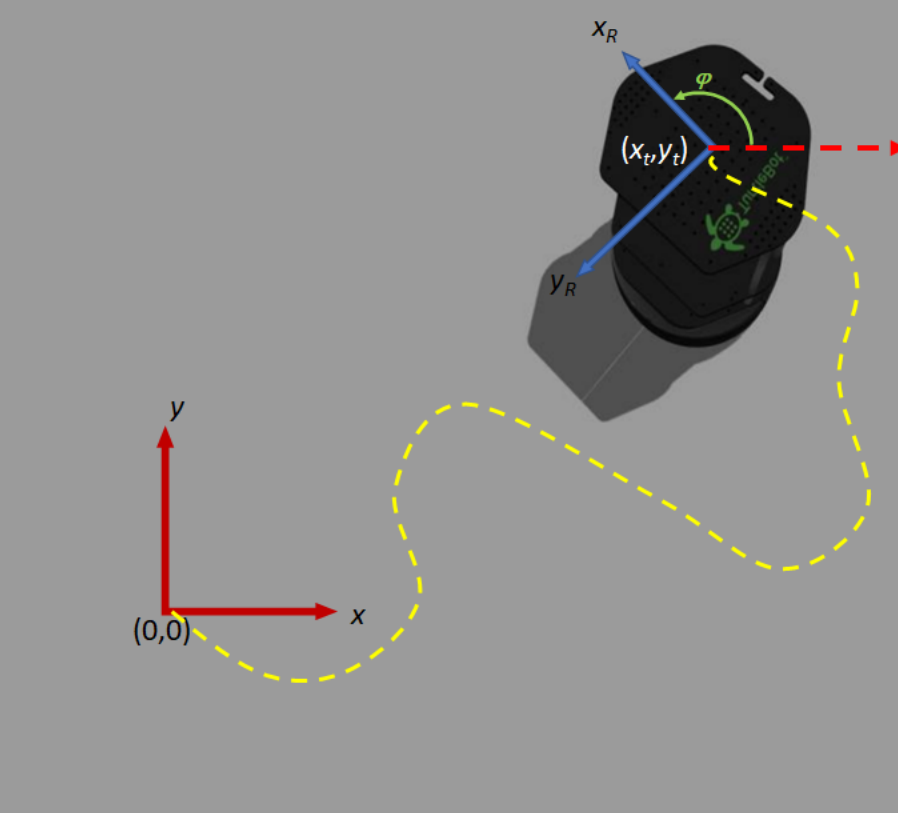
Figure 3. Odometry Module: Relative pose ( x , y ) and ϕ angle of the robot since power-on.